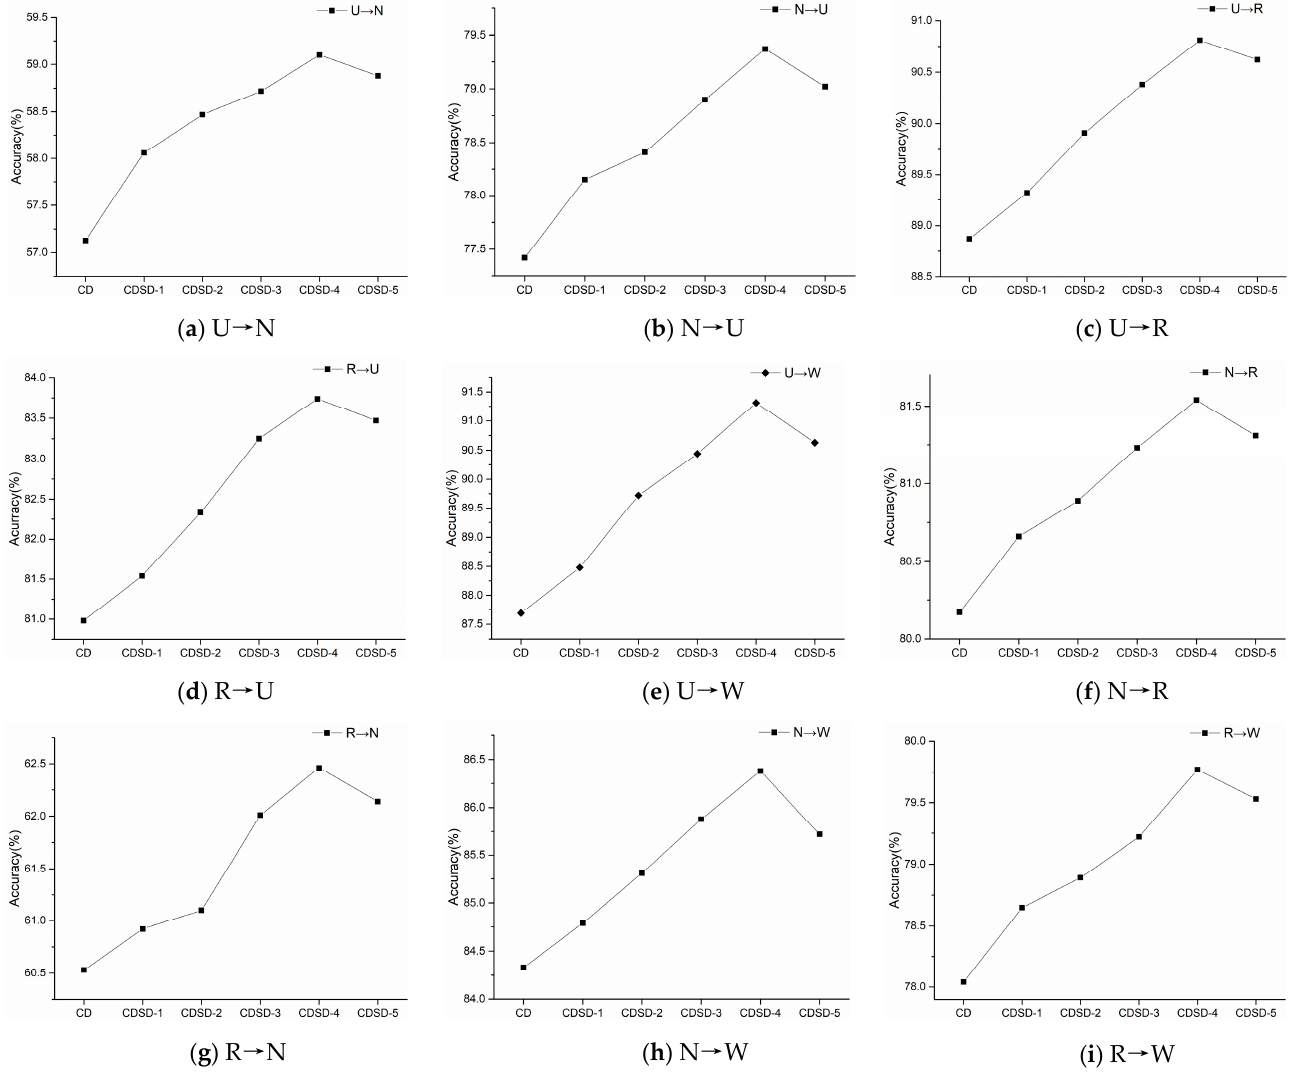
Figure 14. Influence on FAM structure with different convolutional layers.